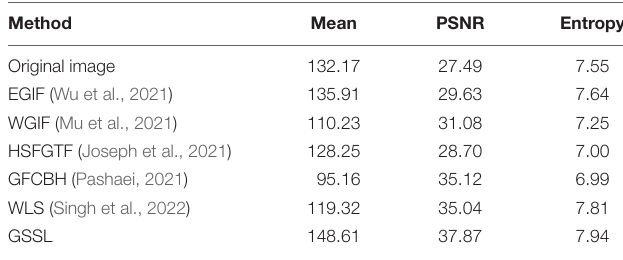
TABLE 4 | Enhanced image quality